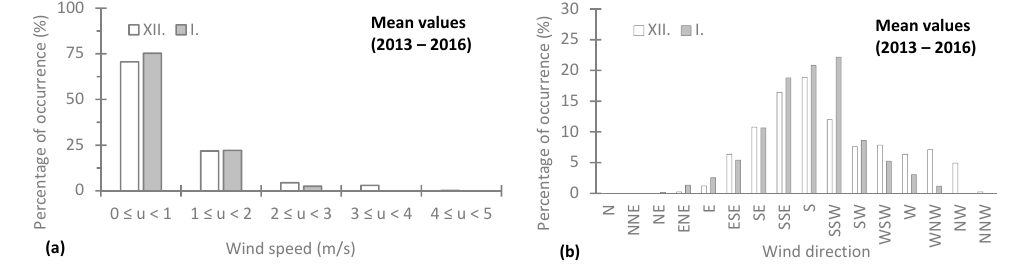
Figure 7. Percentage of ( a ) wind speed (u) and ( b ) wind direction occurrences in December and January during the potential snowmaking days (PSD).